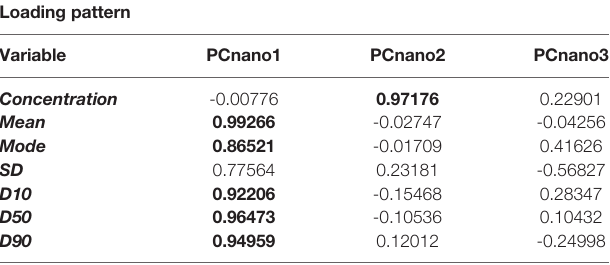
TABLE 2 | Component Loadings.